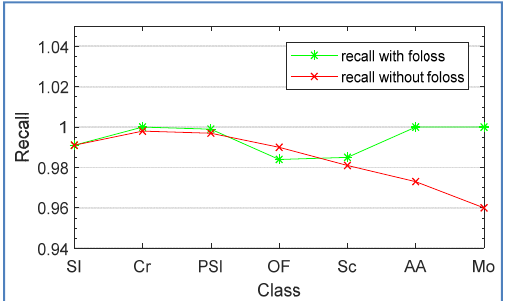
Figure 17. The recall curve of the two methods for each type of defect.